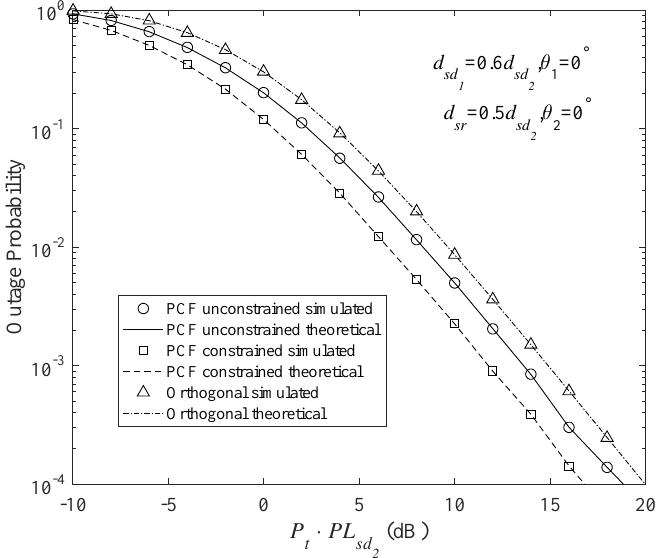
Figure 5. Outage probability of different DF protocols at N d τ 2 = 2 b/s/Hz for the orthogonal multiplexing), PCFs of the PCF-constrained protocol α = 0.5 α max and β = 0.5 α max , PCFs of the PCF-unconstrained protocol α = 0.9 α max and β = 0.5 α max , and transmit powers P r = P s